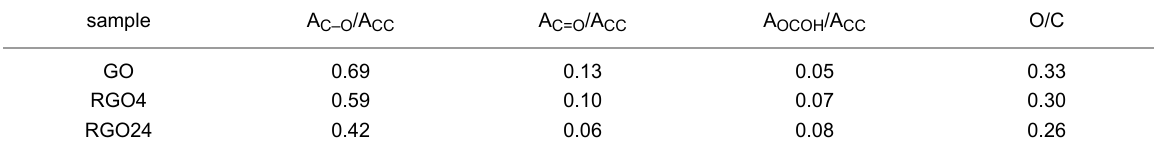
Table 1: Peak area ratios of oxygen-containing bonds to CC bonds and O/C ratio obtained from Figure 2B.